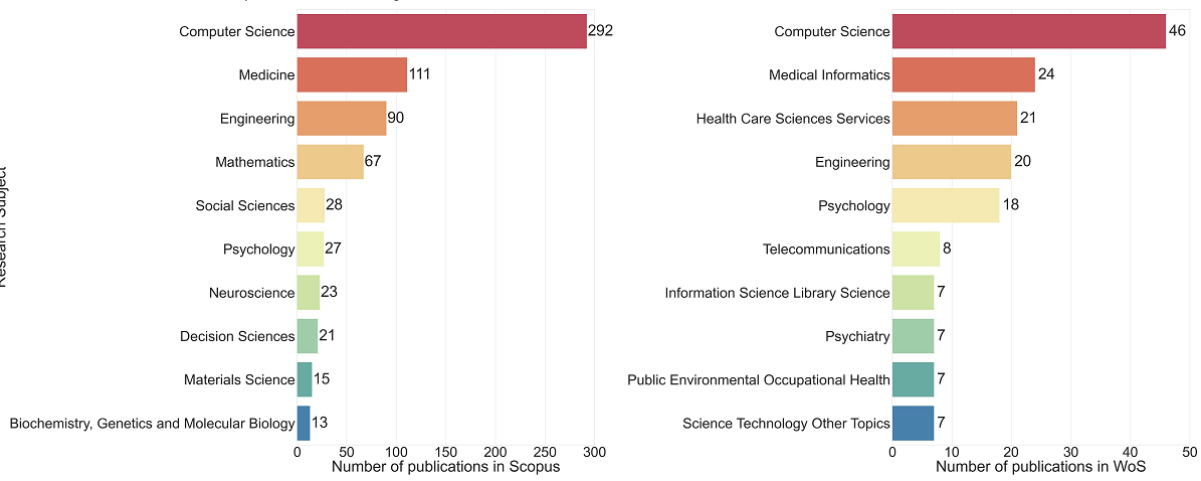
Publication count, n (%)CountryInstitutionAuthor Web of Science (N=115)Scopus (N=450)